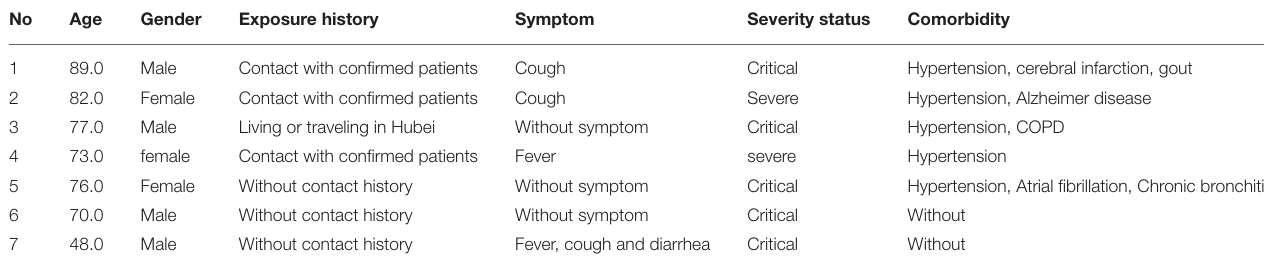
TABLE 4 | Clinical characteristics of seven patients died from